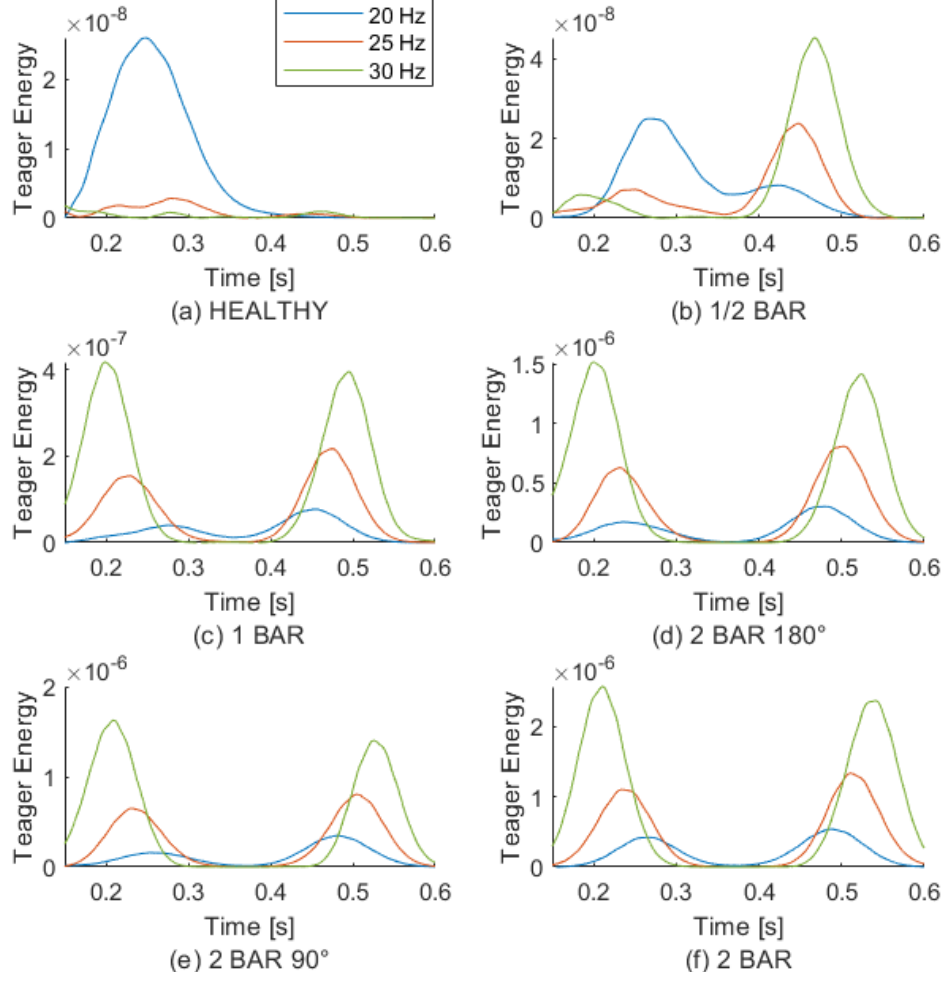
Figure 9. Teager Energy of all rotors (filter centered at f 0 = 20, 25 and 30